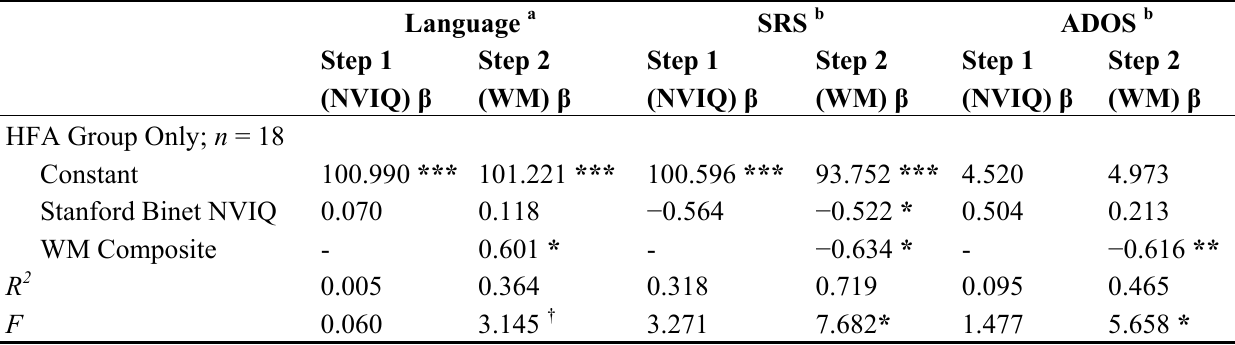
Table 3. Hierarchical multiple regression models of working memory ability predicting language and autism symptom